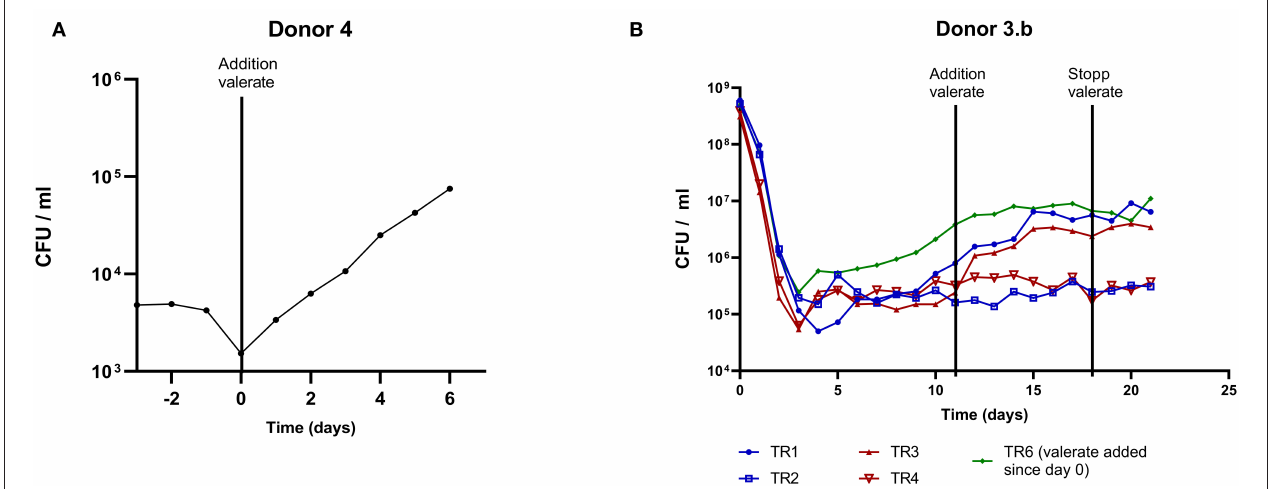
FIGURE 6 | Modulation of the human adult microbiota carrying capacity for L. plantarum by valerate supplementation. Valerate was continuously supplemented after stable L. plantarum microbiota colonization into (A) TR1 containing microbiota of donor 4 and (B) TR1, TR3, and TR6 containing colonic microbiota of donor 3.b, whereas valerate was continuously added to TR6 already since reactor connection. TR2 and TR4 served as control reactors. The x-axis depicts the time of L. plantarum cultivation and the y-axis represents L. plantarum viable cell count per ml reactor effluent. The solid line indicates the start and stop of valerate supplementation. Blue represents L. plantarum NZ3400B and red 1